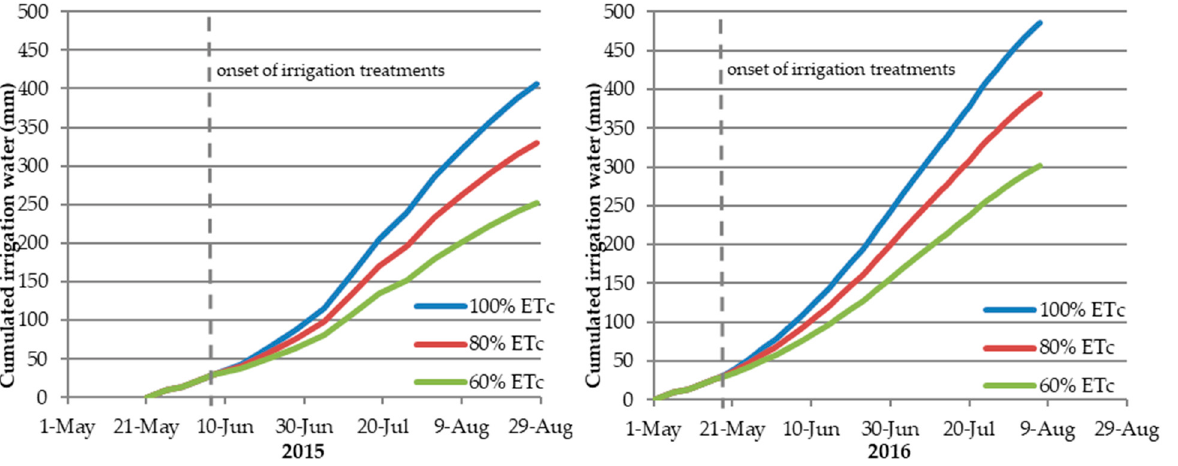
Figure 2. Reference evapotranspiration (ETo), crop evapotranspiration (ETc), and crop coefficients (Kc) calculated and applied over the scheduling irrigation period in the two years of the experiment.